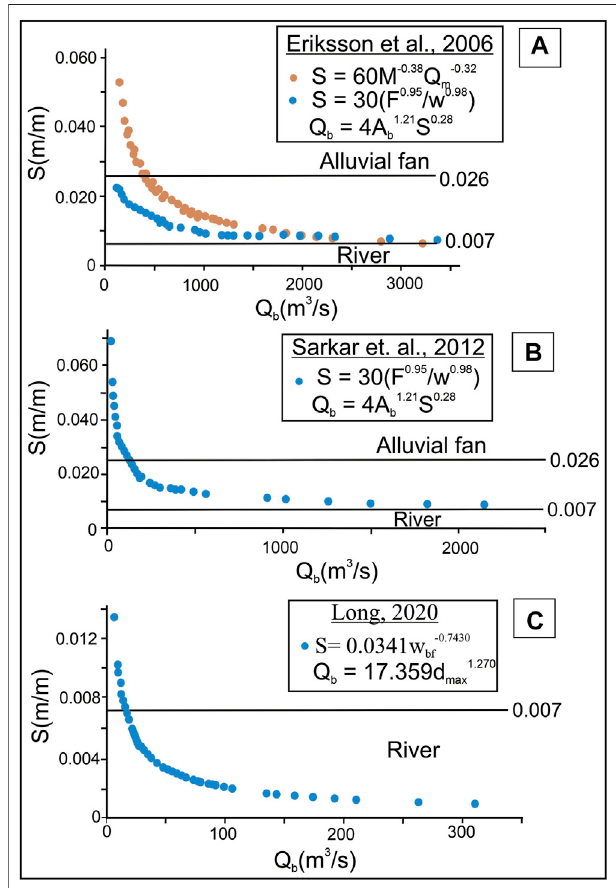
FIGURE 5 | Binary plots of palaeoslope (S) and mean annual bankful discharge values (Qb) for Damdama fl uvial system following (Eriksson et al., 2006) (A) ; (Sarkar et al., 2012); (B) and (Long 2021) (C) . Note dominant plotting of slope values either in the fi eld of an alluvial fan or in the natural depositional gap in panels A and B, whereas plotting of values mostly in the river fi eld in panel (C)